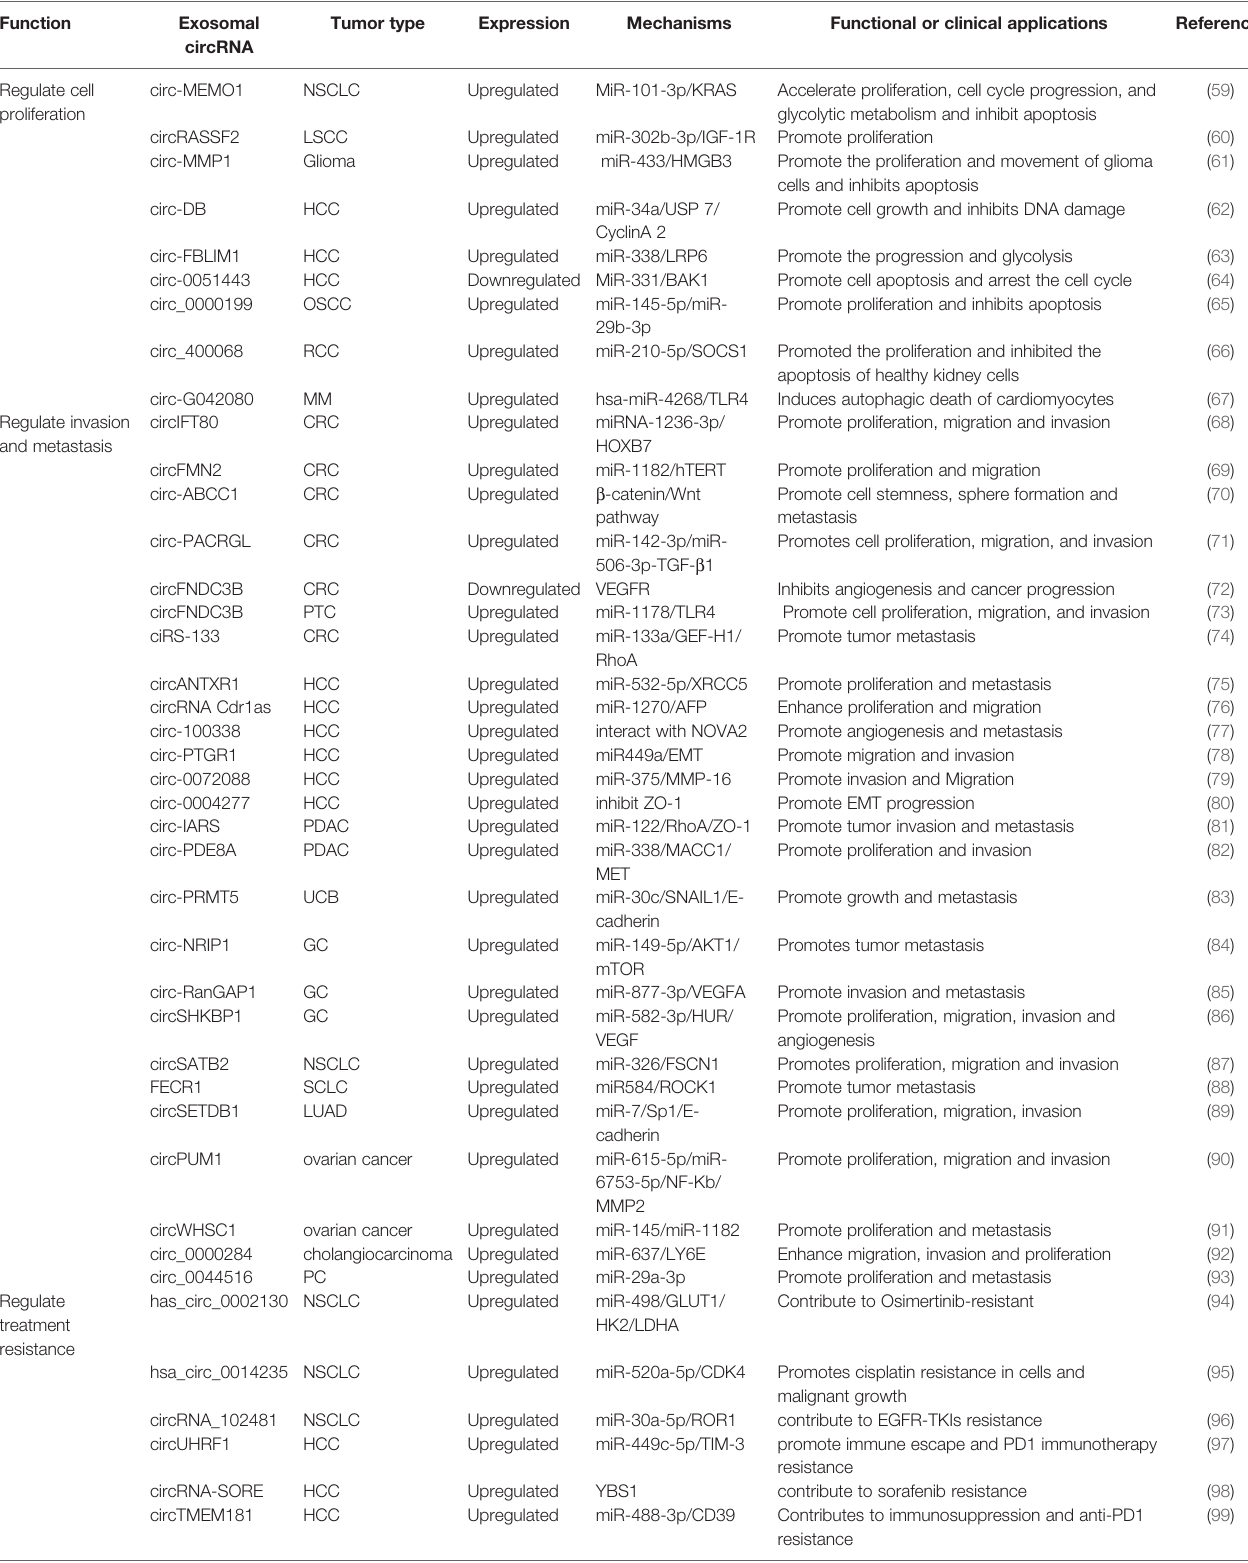
TABLE 1 | Function and clinical signi fi cance of exosomal circRNAs in tumors.